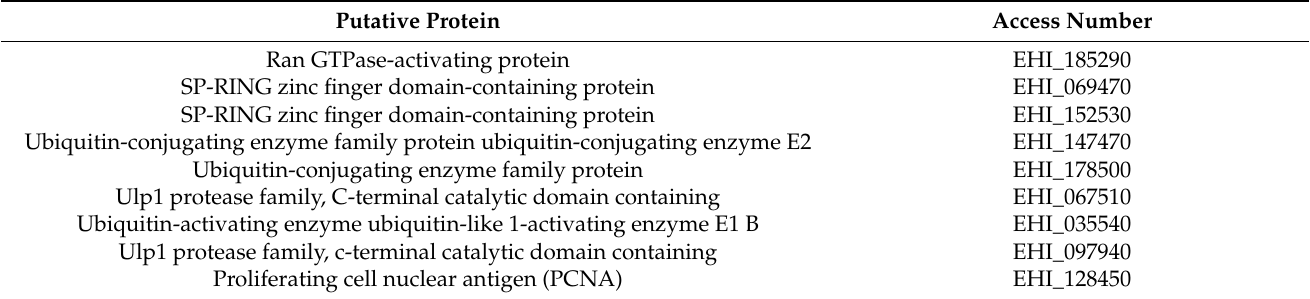
Table 1. In silico interactions of EhSUMO with other E. histolytica putative proteins related to the SUMO machinery. Putative Protein Access